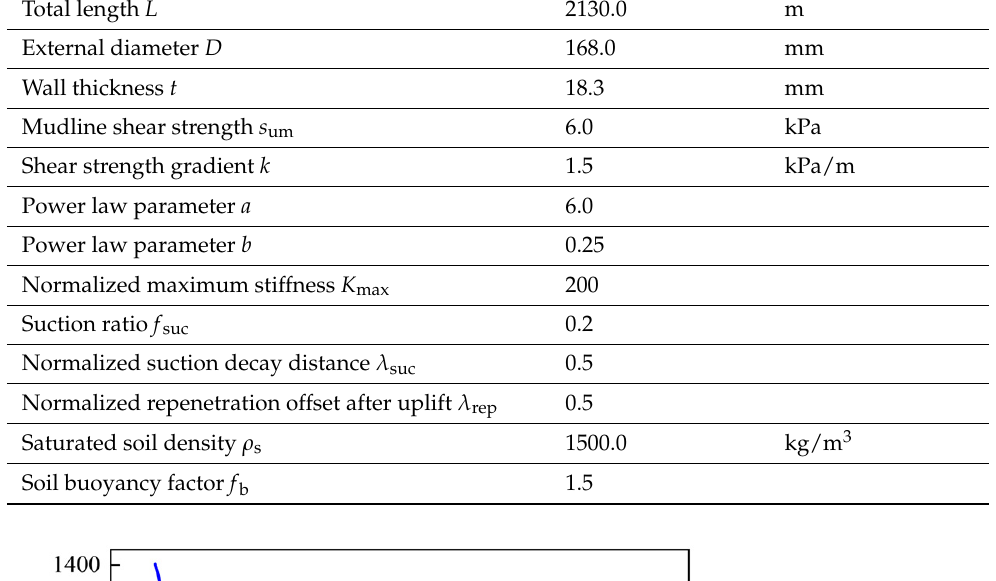
Table 1. Detailed parameters used in the model.